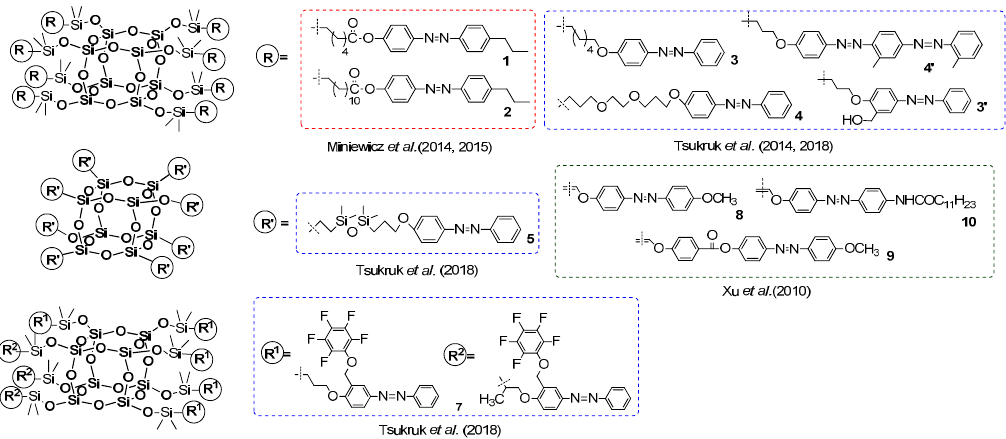
Figure 32. The POSS derivatives with azobenzene-based chromophores obtained by